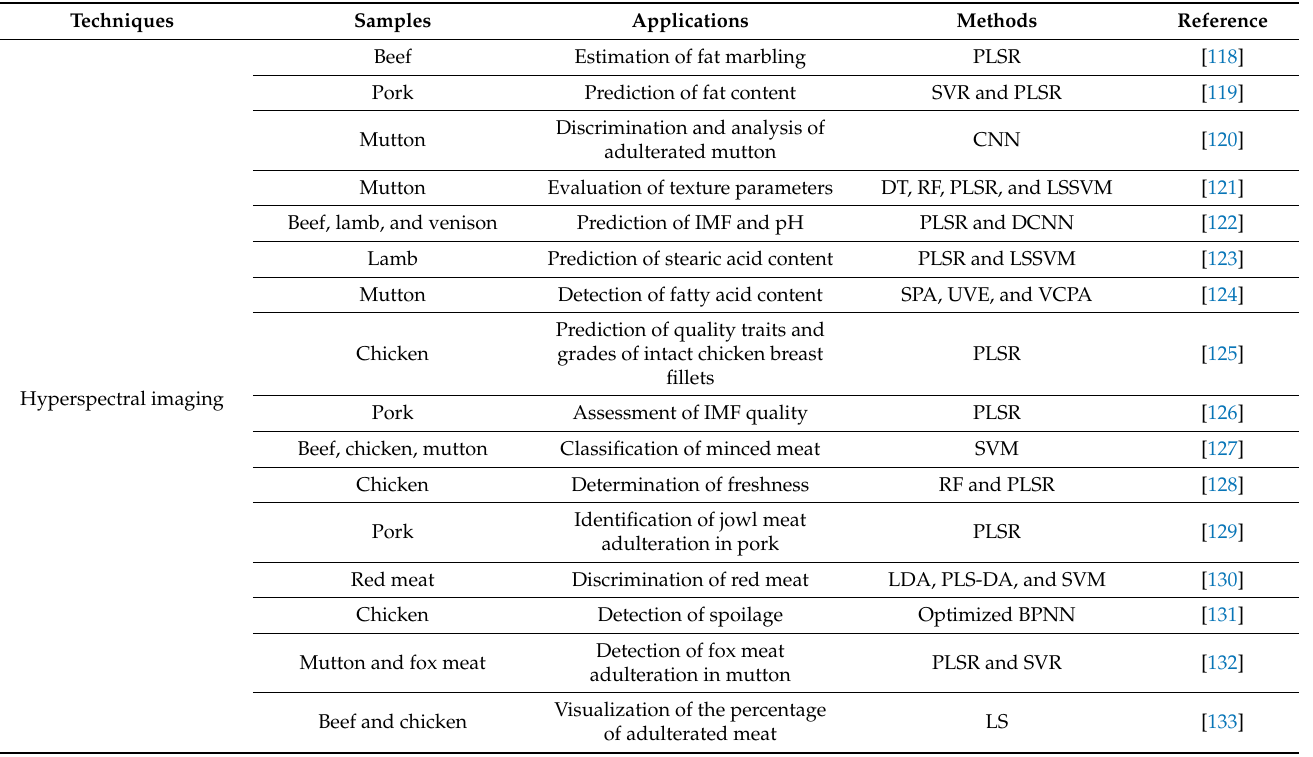
Table 2. Summaries of different imaging techniques applied for meat